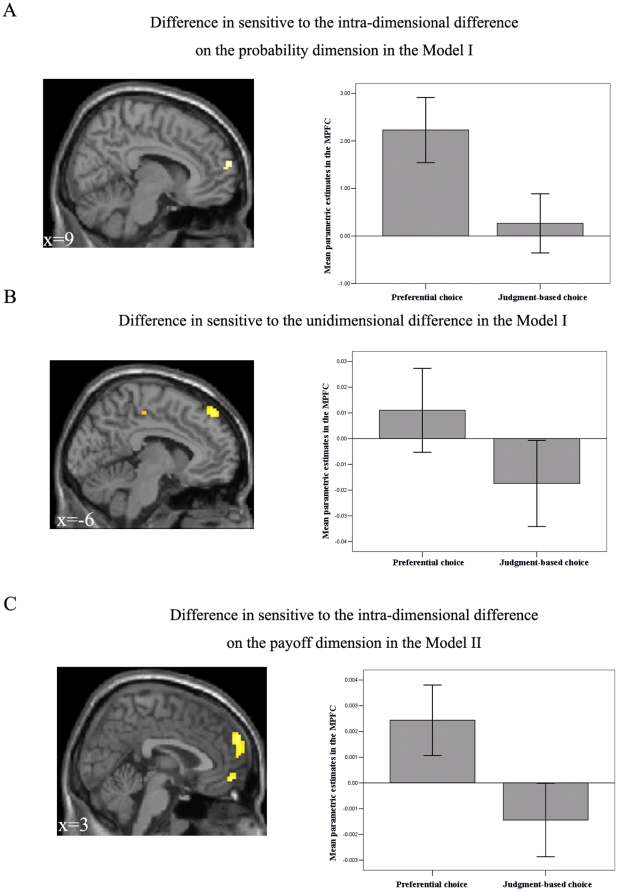
Brain regions tracking variations in decision parameters.MPFC showed differences in sensitivity to the intradimensional difference in the probability dimension in Model I (A), in sensitivity to the unidimensional difference in Model I (B), and in sensitivity to the intradimensional difference in the payoff dimension in Model II (C). In the left column, the region was displayed in a T1-weighted MRI template. In the right column, the mean parameter estimates of the corresponding region in the two choice tasks were shown.